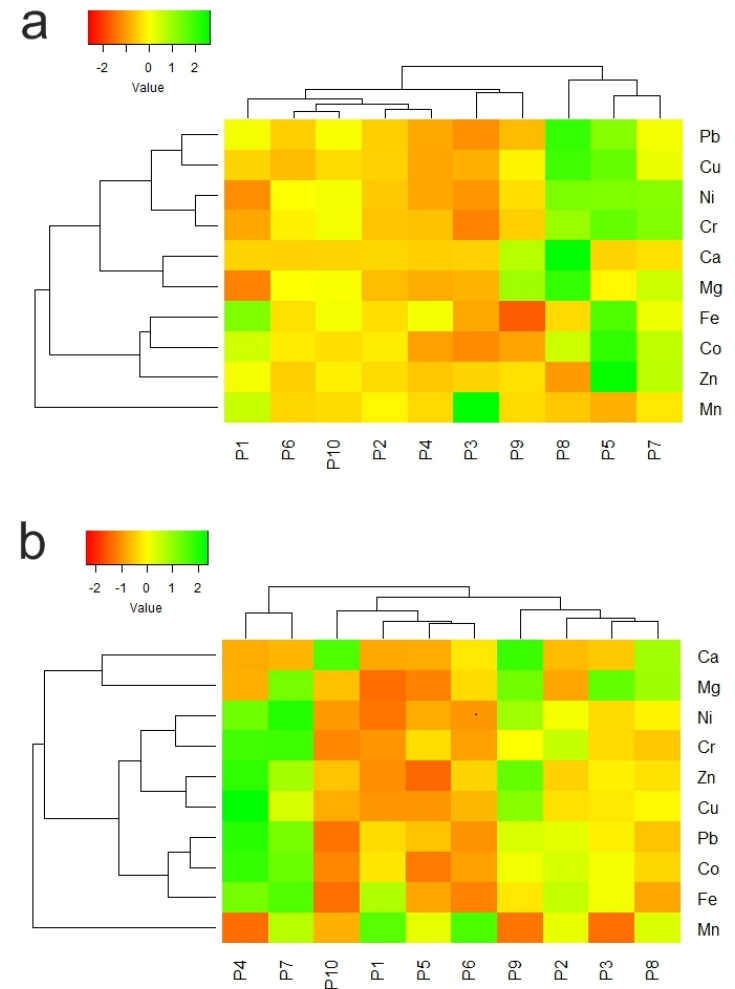
Figure 5. Results of the heat map for HCA from the concentration of the metals obtained by pseudo-total digestion in sediment samples of the Jequiezinho River (a) first campaign, (b) second